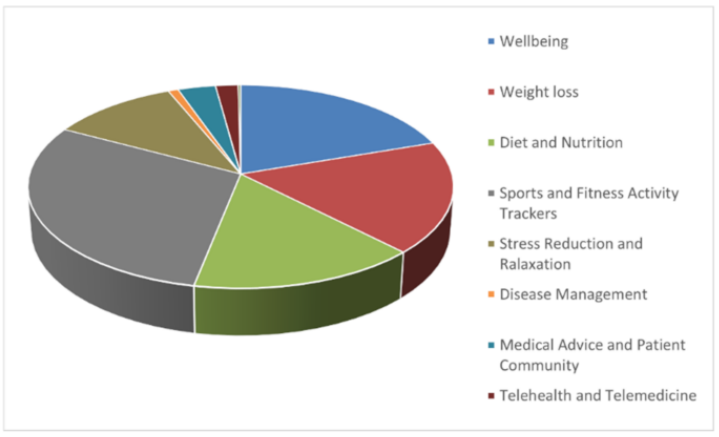
Figure 1. Breakdown of most popular mHealth app